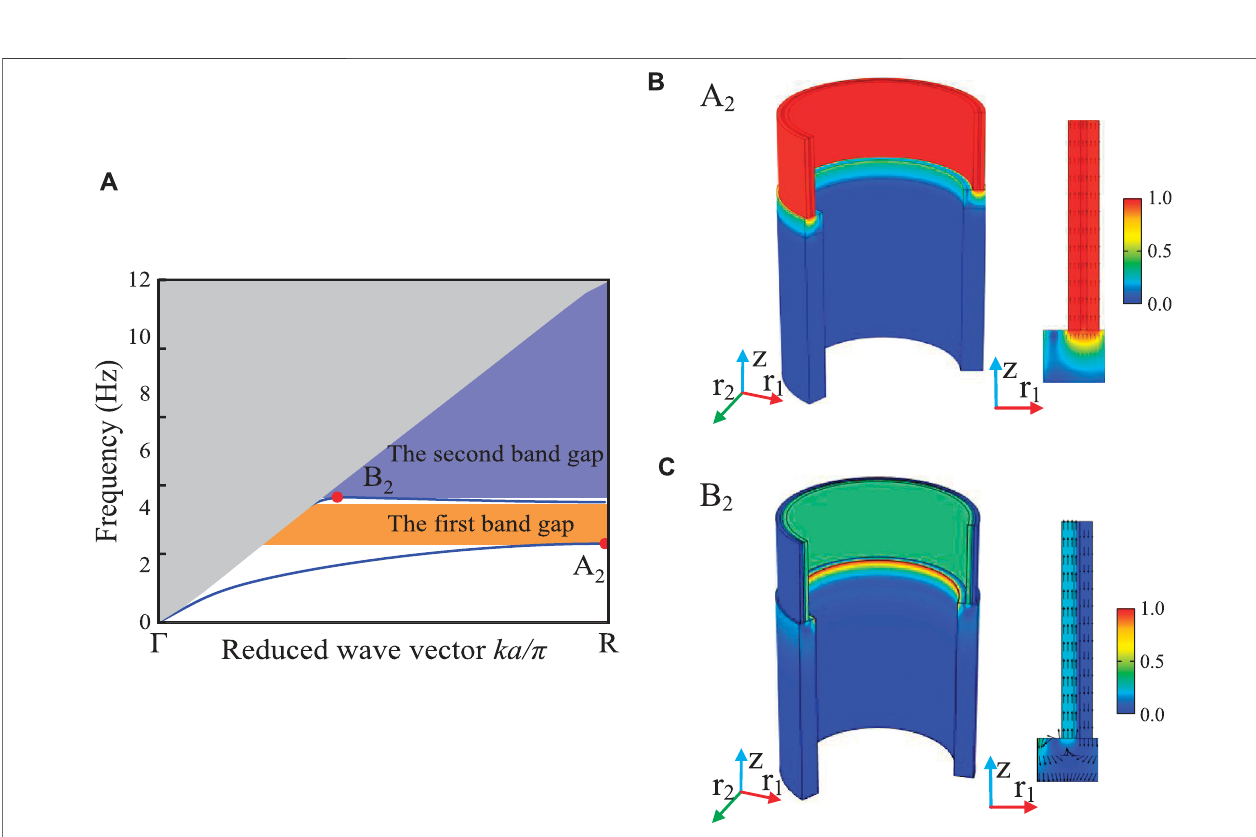
FIGURE3| Dispersioncurve,eigenmodeanddisplacementvector fi eldofLRSM-2: (A) dispersioncurves;eigenmodeanddisplacementvector fi eldat (B) pointA 2 and (C) point B 2 . Colors represent the displacement amplitude, and black arrows represent the displacement direction.